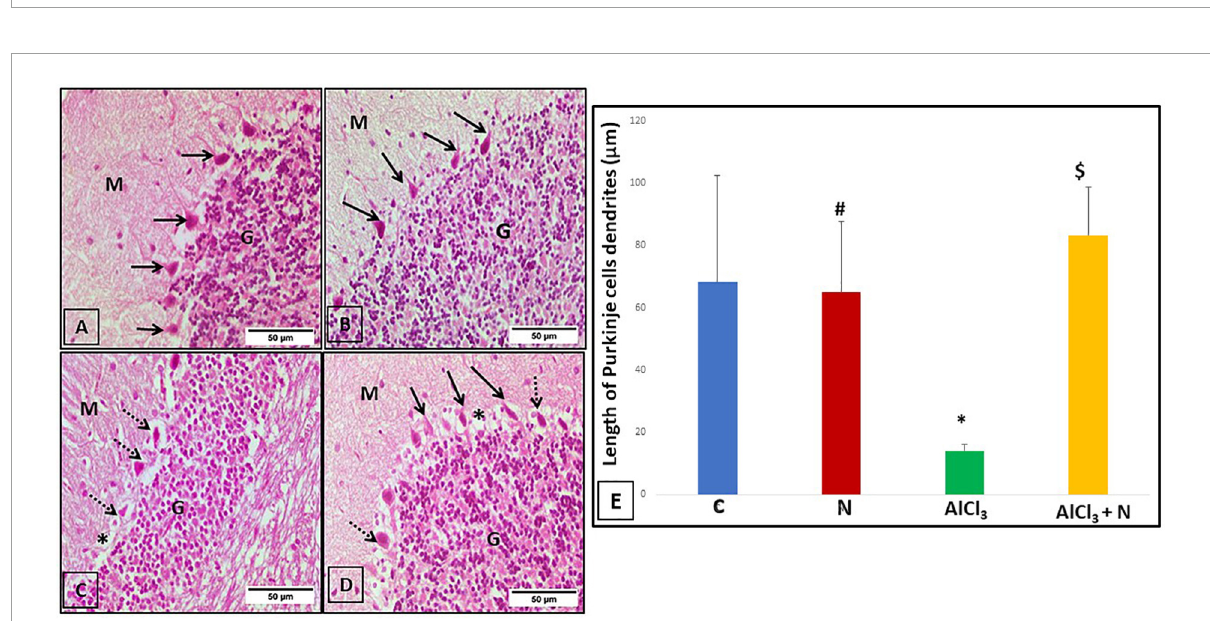
FIGURE6 Cerebellar sections stained with H & E-stained cerebellar sections of the studied groups: (A,B) C and N groups, respectively, showed the three layers of the cerebellar cortex: molecular layer (M), Purkinje cell layer (arrows) and granular layer (G). Purkinje cells appeared pyriform in shape, with apical dendrite projecting upwards in the molecular layer. (C) The AlCl 3 group showed normal appearance of both molecular (M) and granular (G) layers. Purkinje cells had a distorted shape with lost apical dendrites (arrows). (D) The AlCl 3 + N group showed normal appearance of the molecular (M) and granular (G) layers. Most of the Purkinje cells appeared to be normal in shape having apical dendrites (arrows). However, some of the Purkinje cells had a distorted shape with the loss of their apical dendrites (dotted arrows). Also, there were empty spaces ( ∗ ) indicating neuronal degeneration (H & E, × 400). (E) Length of the Purkinje cell dendrites of all studied groups. n = 6 in each group. Data were prescribed as mean ± SD . The intergroup variation was conducted by Games-Howell post-hoc test. ∗ p < 0.001 compared with C group. # p < 0.001 compared with AlCl 3 . $ p < 0.001 compared with AlCl 3